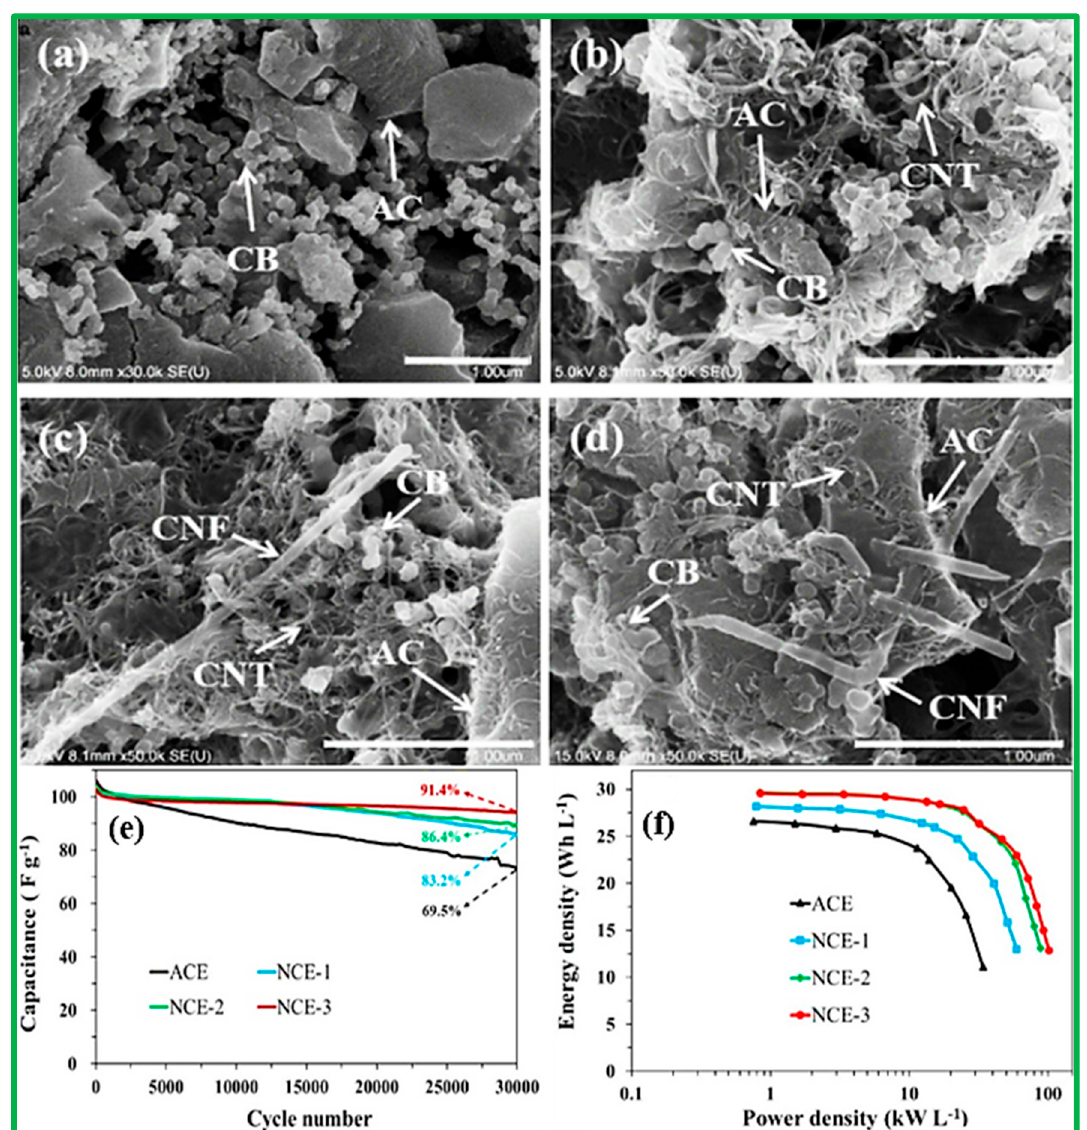
Figure 6. SEM images of ( a ) binary ACE (activated carbon electrode) composite electrode, with the weight percentage of 90 to 5 for activated carbons (AC)/carbon black (CB). ( b ) Ternary NCE-1 composite electrode (with the composition of AC/CB/carbon nanotube (CNT) (90/1.25/3.75)). ( c ) Ternary NCE-2 composite electrode (with the composition of (AC/CB/CNT/carbon nanofibers (CNF) (90/1.25/3.125/0.625)). ( d ) Quaternary NCE-3 composite electrode (with the composition of AC/CB/CNT/CNF (88.75/1.25/3.75/1.25)). ( e ) Capacitance retentions of various composite electrodes. ( f ) Ragone plots of the performance of various composite electrodes according to the total volume of the coating films of the two electrodes of the device. Reprinted with permission from [104], Copyright 2019, Elsevier.